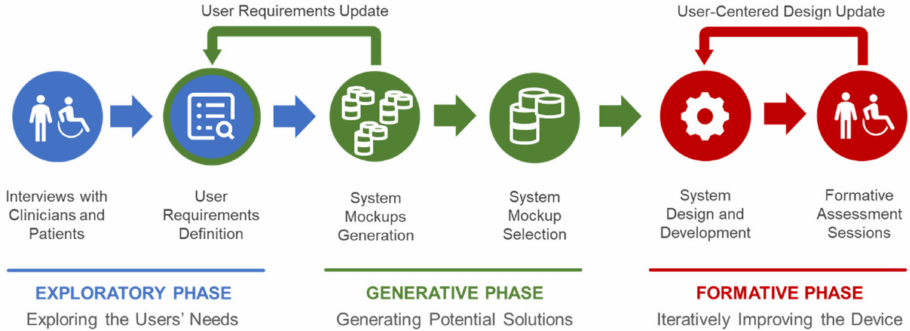
Figure 1. The user-centered design process adopted to achieve the current version of